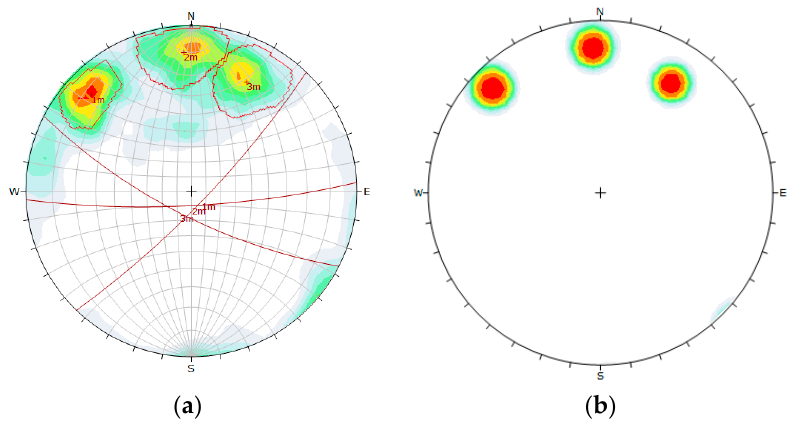
Figure 15. Isodensity analysis of poles in the experimental area: ( a ) isodensity map of poles using the method in this paper; ( b ) field-measured pole density map.